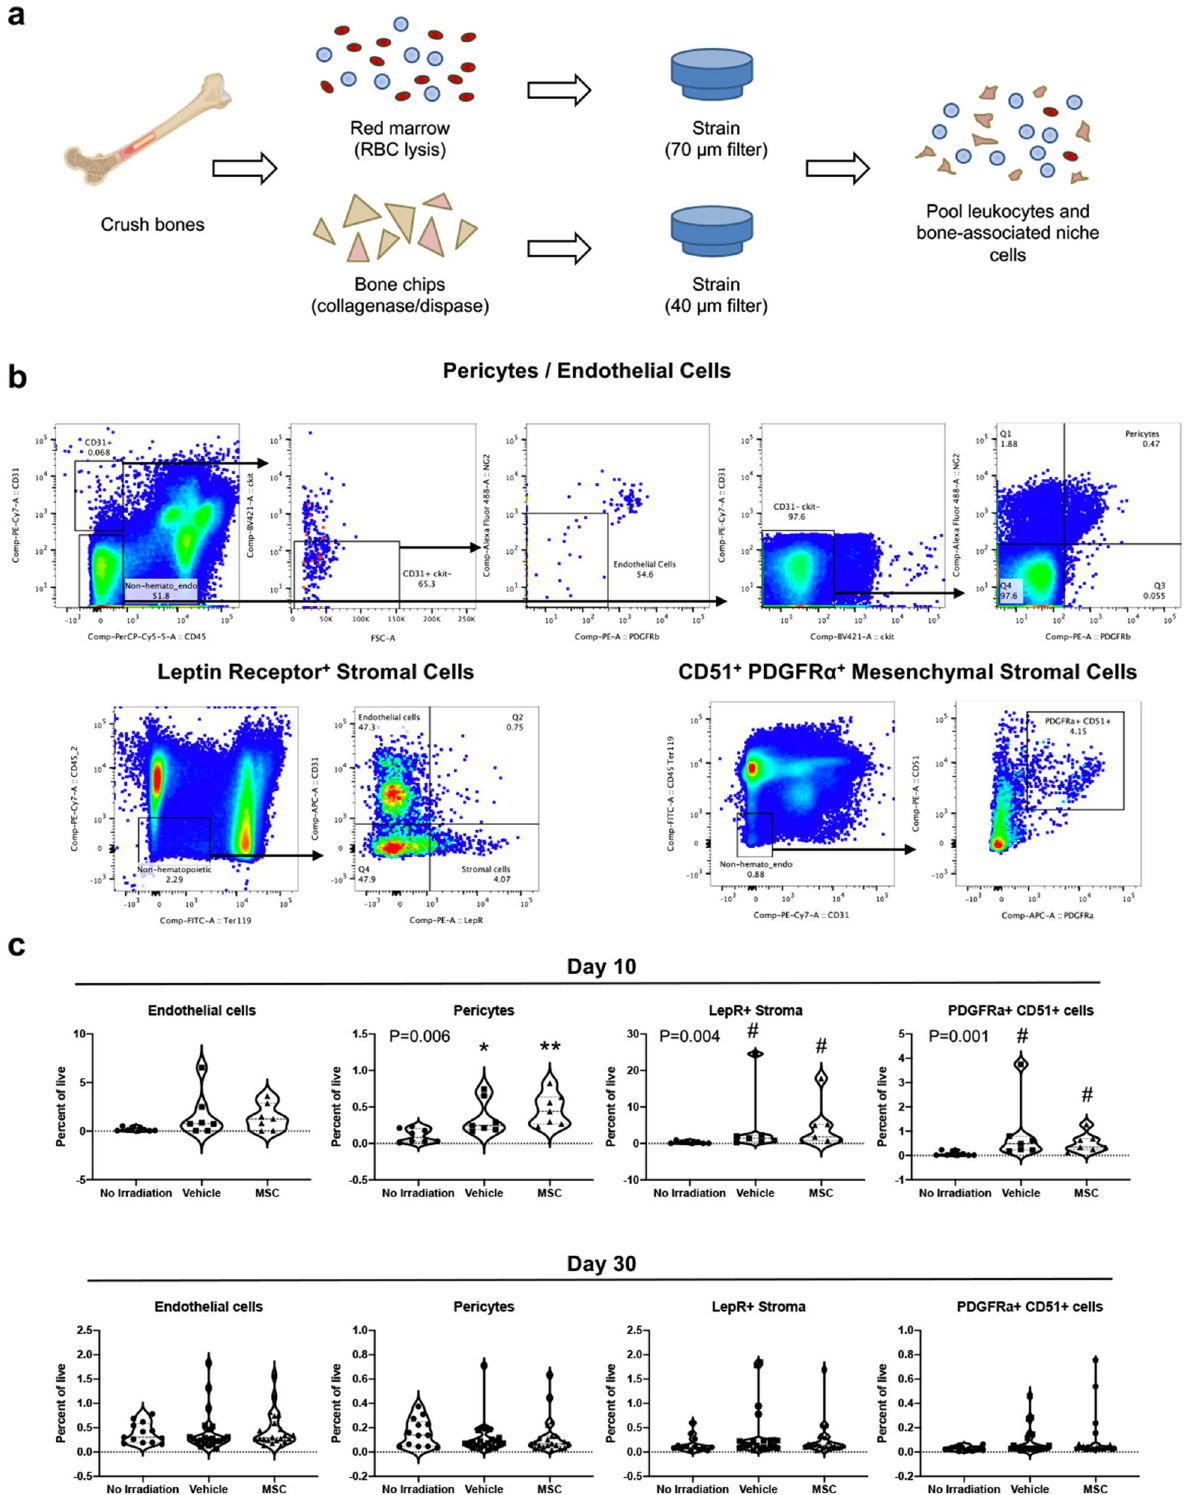
Figure 5. Cellular composition of the niche appears unchanged by MSC therapy. ( a ) Schematic overview of bone marrow isolation for analysis of hematopoietic and non-hematopoietic cells. ( b ) Representative flow cytometry plots show gating strategies used to define specified niche cell subsets. ( c ) Loss of hematopoietic cells from the marrow in irradiated mice results in greater relative frequencies of niche cells, although no significant differences exist between vehicle and MSC groups. Statistical significance of differences between groups is depicted on the graphs. Posthoc comparisons are demarcated by asterisks * P < 0.05 and ** P < 0.01 for Holm– Sidak (One-way ANOVA) or pound symbol # P < 0.5 for Dunn’s (Kruskal–Wallis One-way ANOVA) analyses relative to No irradiation